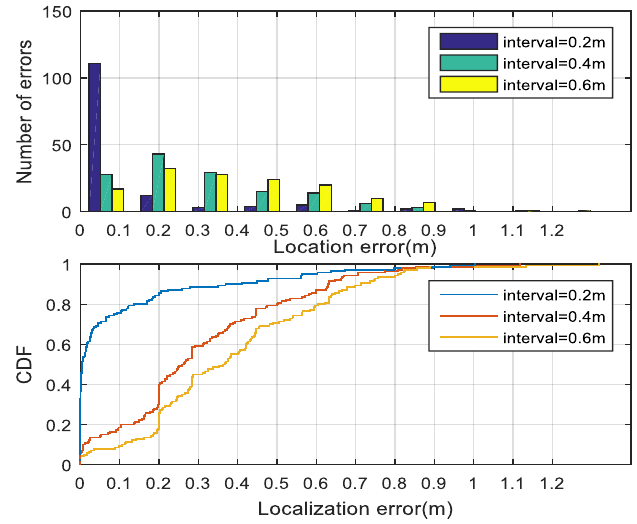
Figure 14. Localization accuracy under different fingerprint scale conditions. Table 2. Performance comparison of different fingerprint scales.